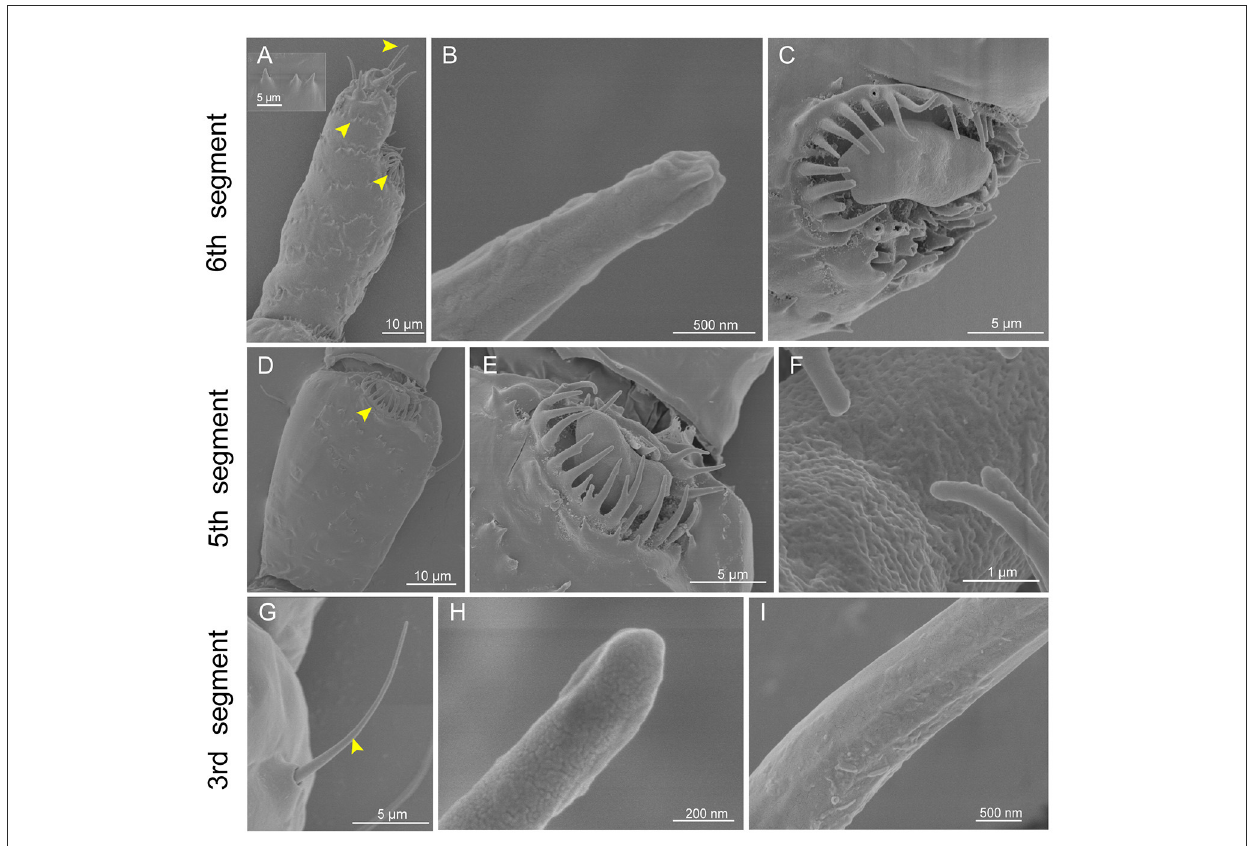
FIGURE3 Scanning electron micrographs of Eriosoma lanigerum antennae. (A) A view of the 6th segment of the primary rhinarium (arrowhead on right), type II trichoid sensilla (arrowhead on top), and spikeweed-like protrusions on the surface (arrowhead on left). (B) An enlarged view of type II trichoid sensilla showing a finger-like pore slit on the tip. (C) An enlarged view of the large placoid sensillum of the primary rhinarium on the 6th segment (LP6). (D) The primary rhinarium on the 5th segment consists of one large placoid sensillum (LP5) (yellow arrowheads). (E) An enlarged view of LP5. (F) LP5 with a porous surface. (G) Type I trichoid sensilla (yellow arrowhead) located on the 3rd segment. (H, I) Details of type I trichoid sensilla showing a smooth surface (I) with no pore structures on the tip (H) .